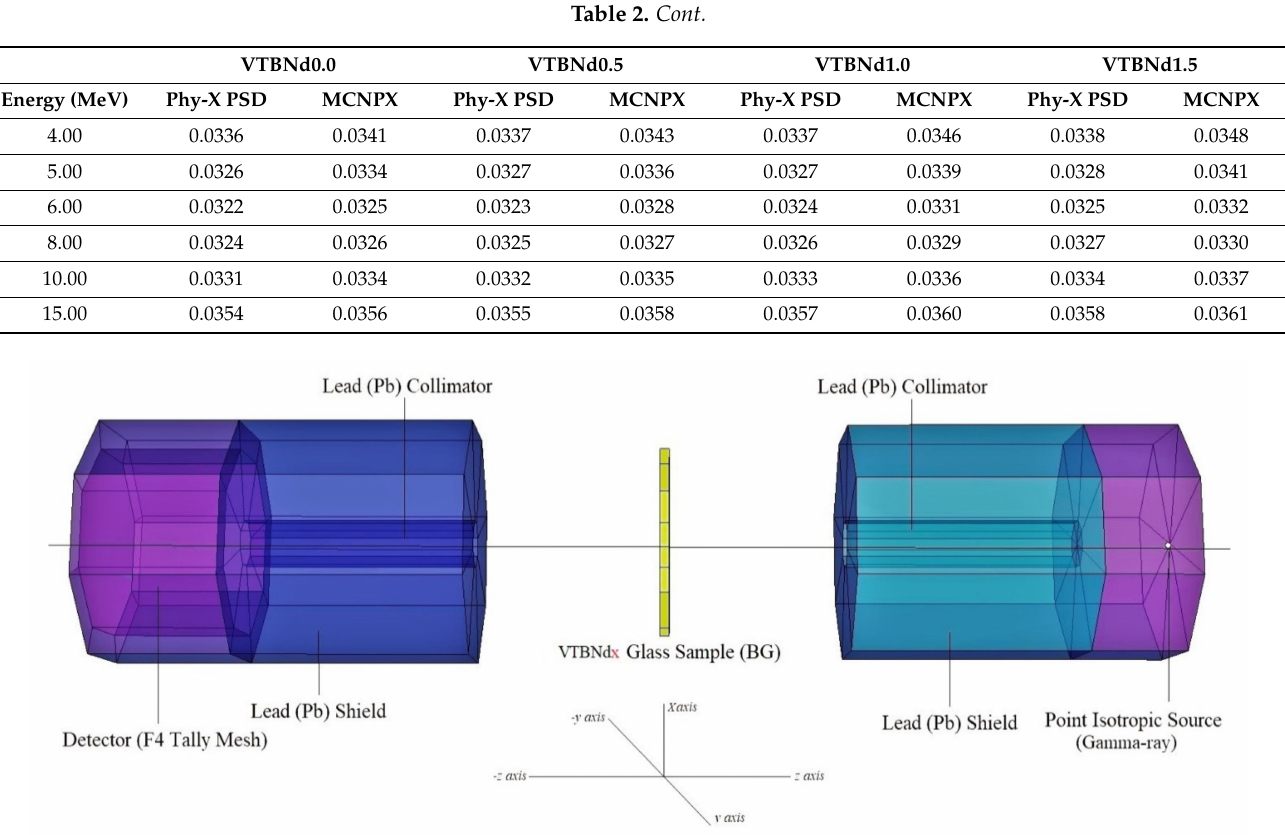
Figure 1. MCNPX simulation setup for gamma-ray transmission studies (MCNPX Visual